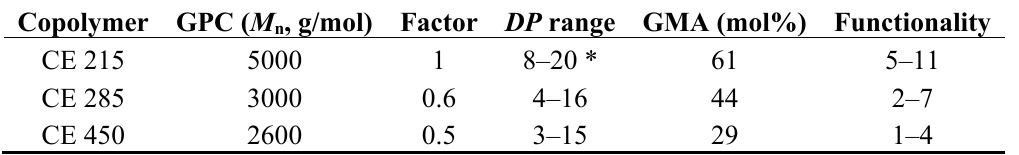
Table 3. Estimation of degree of polymerization ( DP ) and functionality of the copolymers.